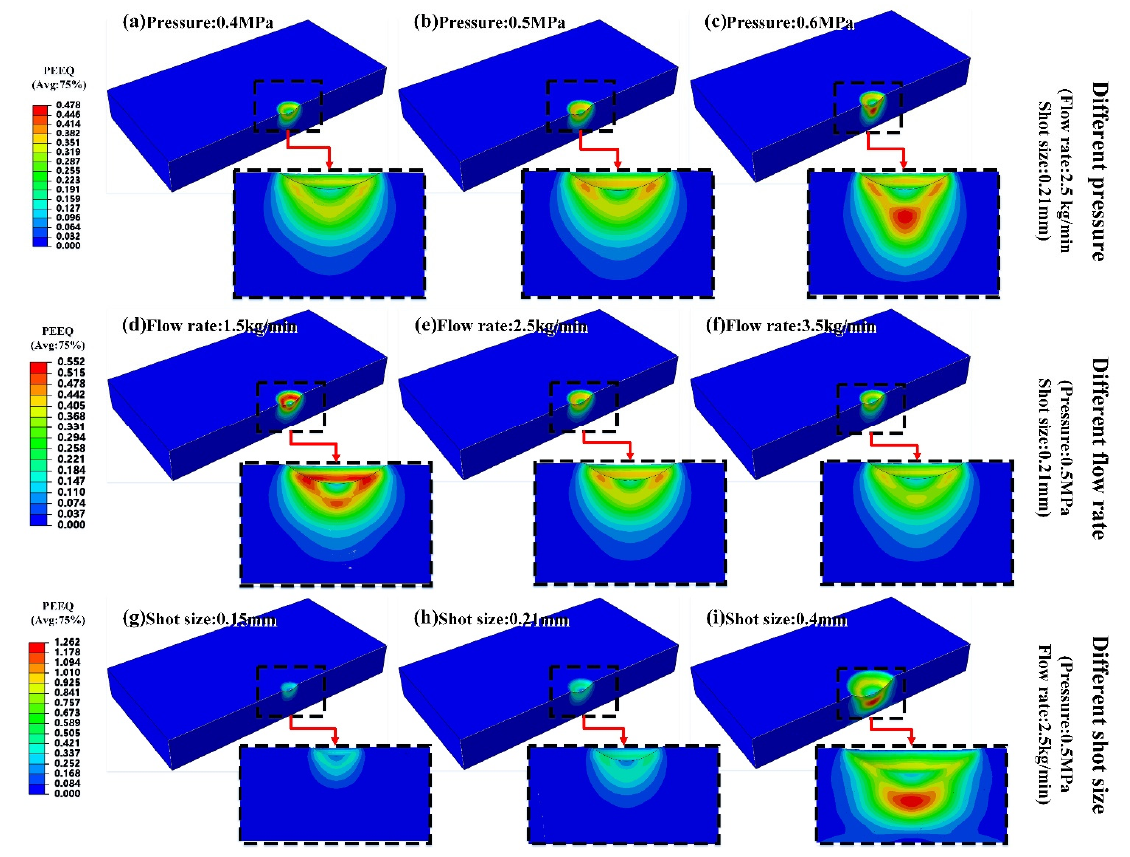
Figure 9. The effect of impact times on PEEQ distribution of coatings under different conditions: ( a – i ) corresponds to the conditions shown in Table 2.